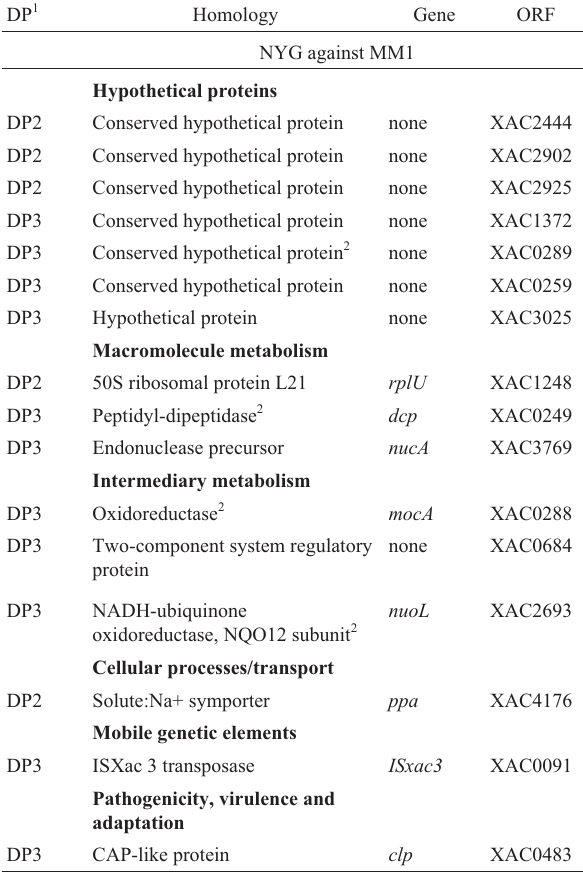
Table 2 - Differentially expressed genes, regulated in the complex medium NYG detected by cDNA RDA.